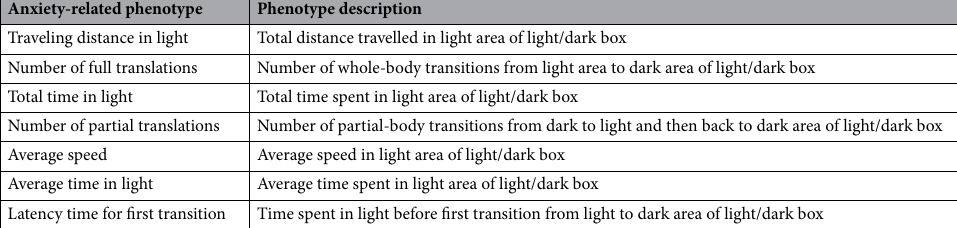
Table 1. Description of anxiety-related